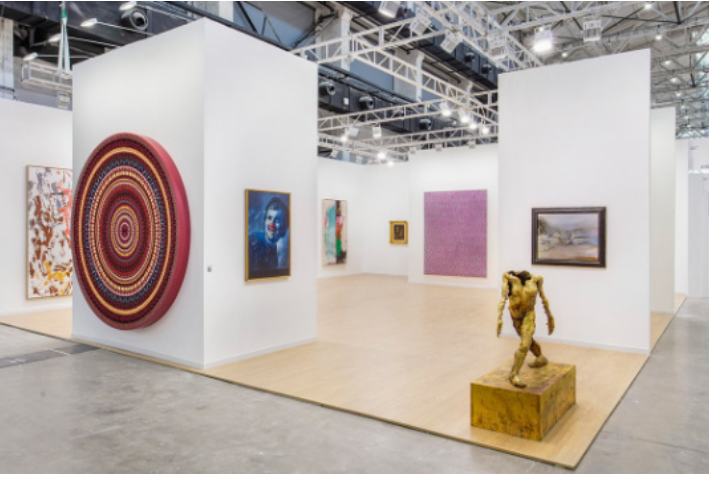
Figure 7. Gagosian’s booth at ART021 Shanghai 2021. Image Courtesy: Gagosian and JJYPhoto.